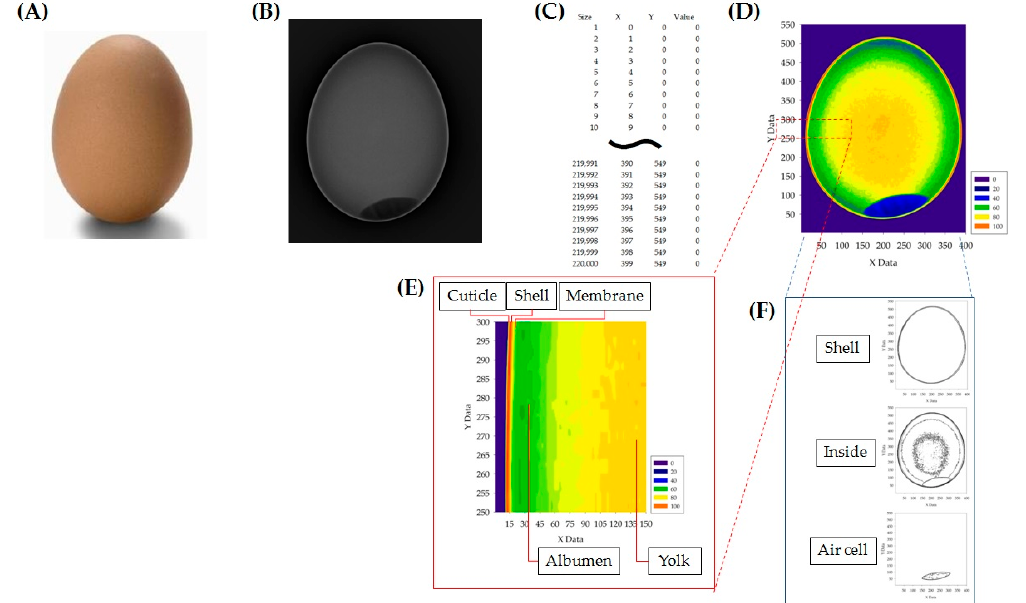
Figure 1. Process of stratified visual analysis of radiography. ( A ) physical egg, ( B ) egg through a photometric interpretation of monochrome gray-scale digital radiography, ( C ) the outputted matrix containing the grayscale value of each pixel and its XY coordinate position, ( D ) the egg image with different color layer signals using a gray-to-color scale conversion, ( E ) three-layer structure of an eggshell, i.e., cuticle, shell, and membrane, in a partially enlarged view of an egg image with different color layer signals, and ( F ) stratification analysis imaging of visualized gray-scale values based on the classified groups.